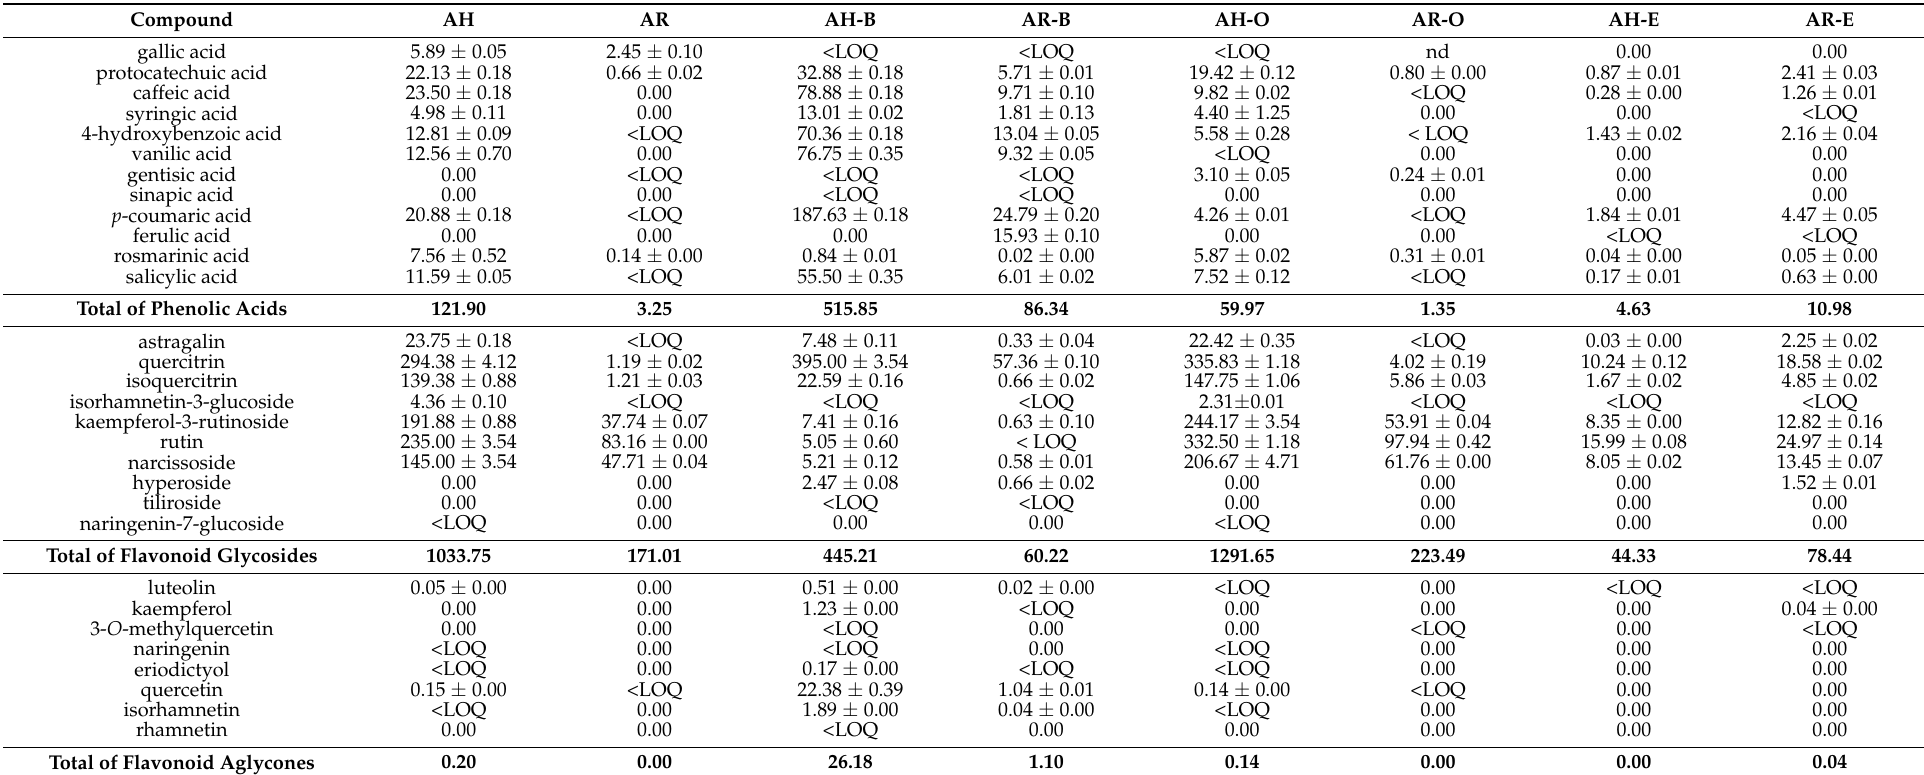
Table 2. Content [ µ g/g DE] of phenolic acids and flavonoids in the aerial parts and roots of A. acutiloba